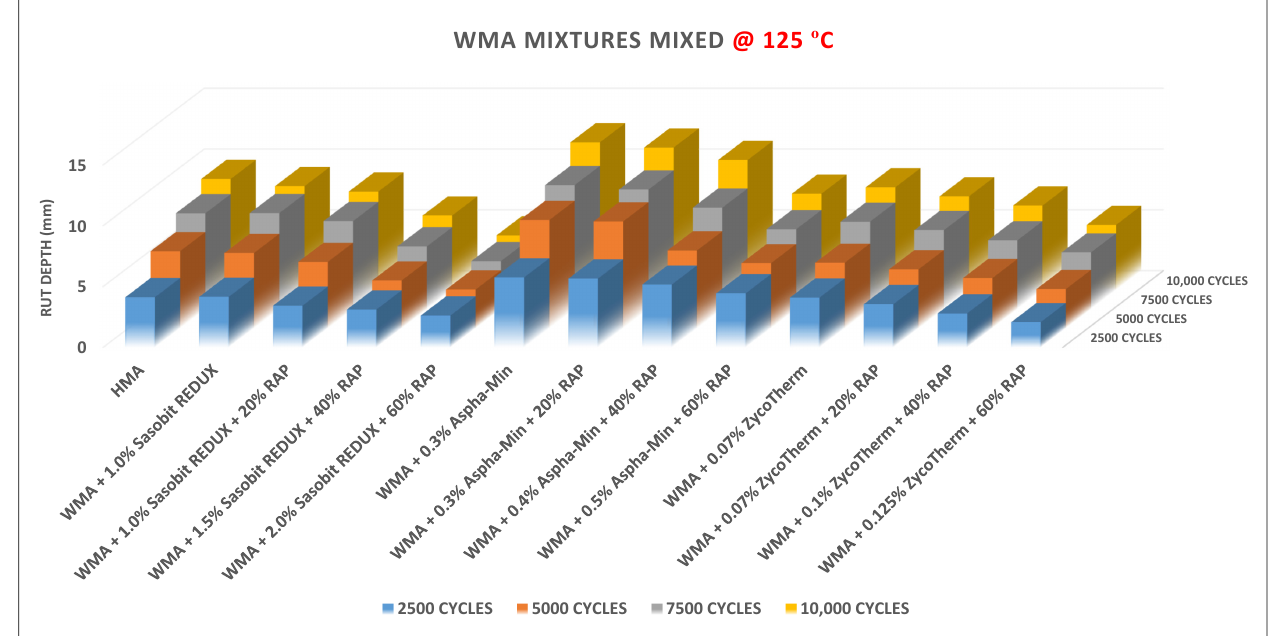
Figure 23. Rutting depth for the modified virgin and recycled WMA mixtures mixed @ 125 °C. 2- WMA Mixtures Mixed at 115 ◦ C (virgin and recycled ones) WMA mixture with 1.0% Sasobit REDUX showed considerable resistance to rutting, whereas the rutting depth for this mixture is insignificantly higher than the control HMA mixture. The WMA mixture with (1.0% Sasobit REDUX + 20% RAP) showed high resistance to rutting similar to the control HMA mixture. The WMA mixture with 0.3%